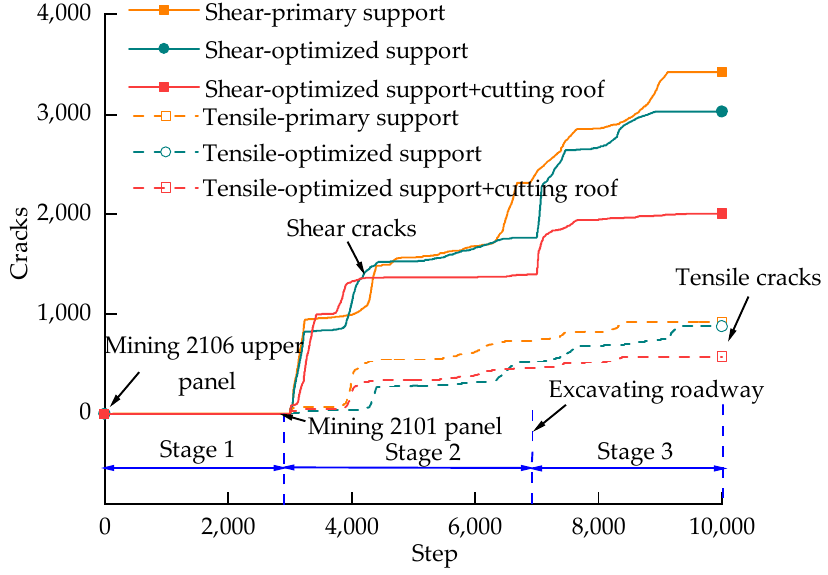
Figure 14. Number of shear and tensile cracks with increasing calculation steps.